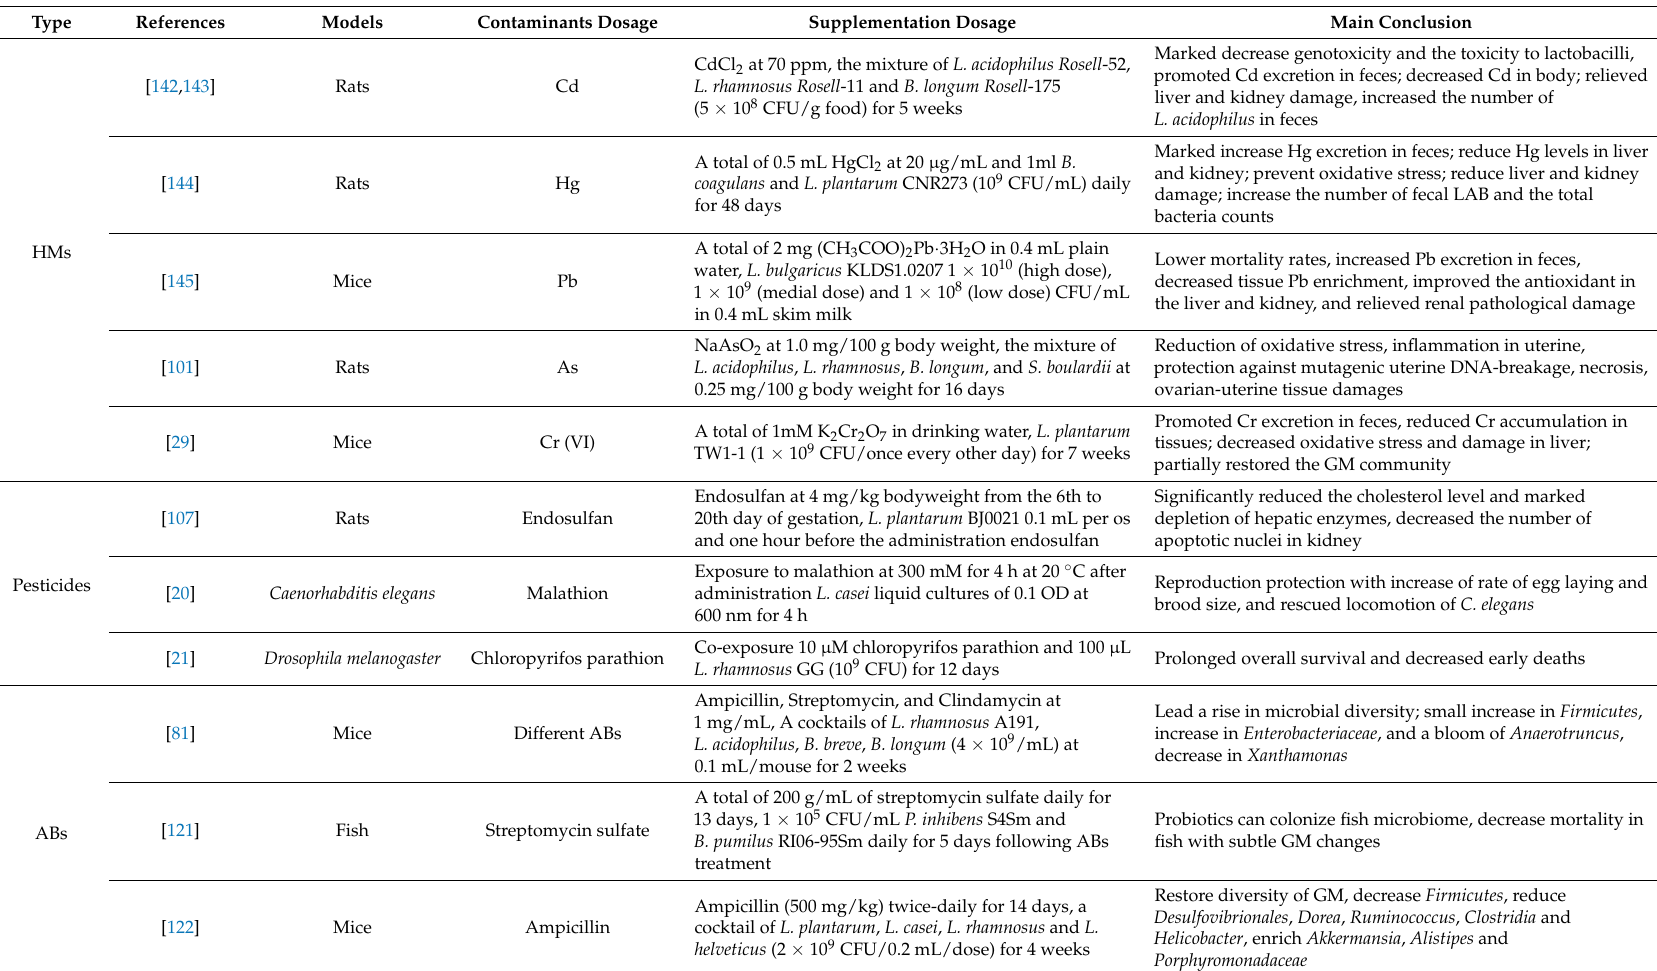
Table 2. Recent studies on the protective effects of probiotics against foodborne contaminants